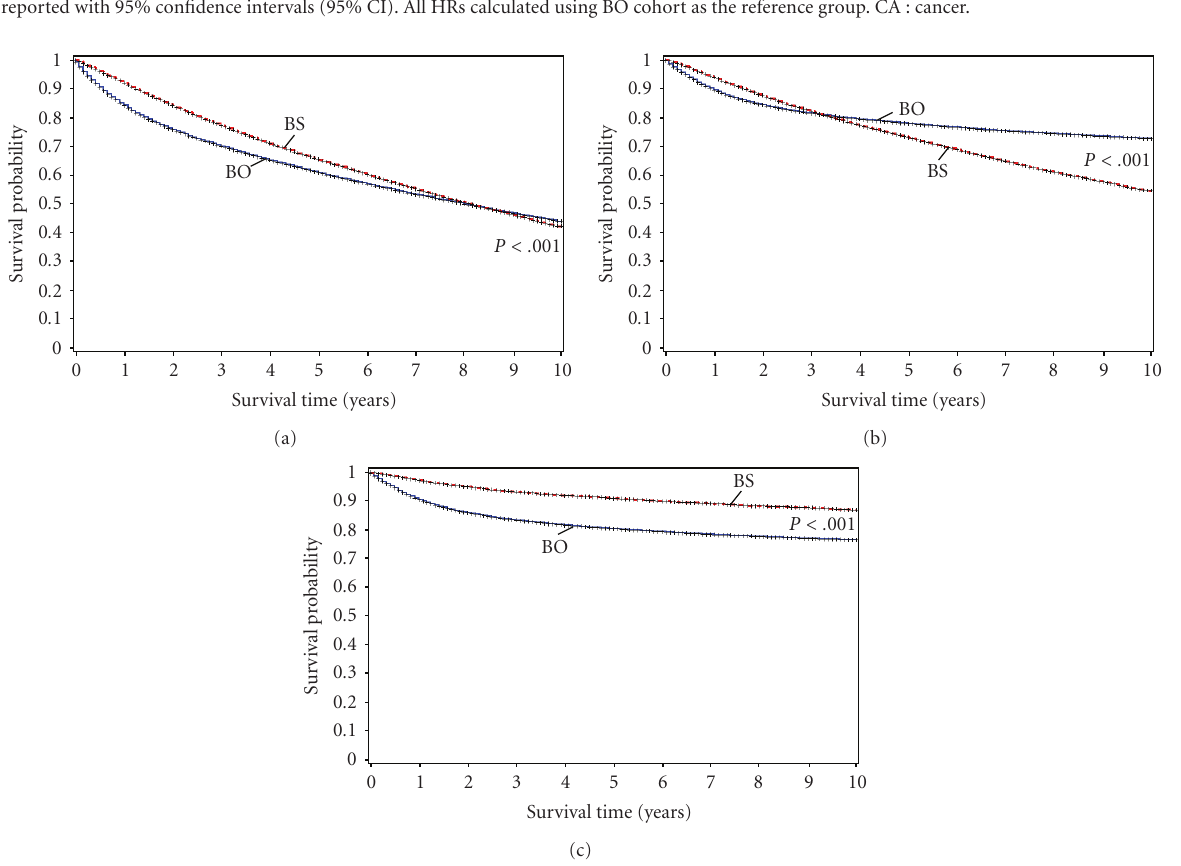
Figure 1: Kaplan-Meier curves comparing (a) overall, (b) cancer-specific and (c) bladder cancer-specific survival of bladder cancer only and BS patients with data censored at a 10-year